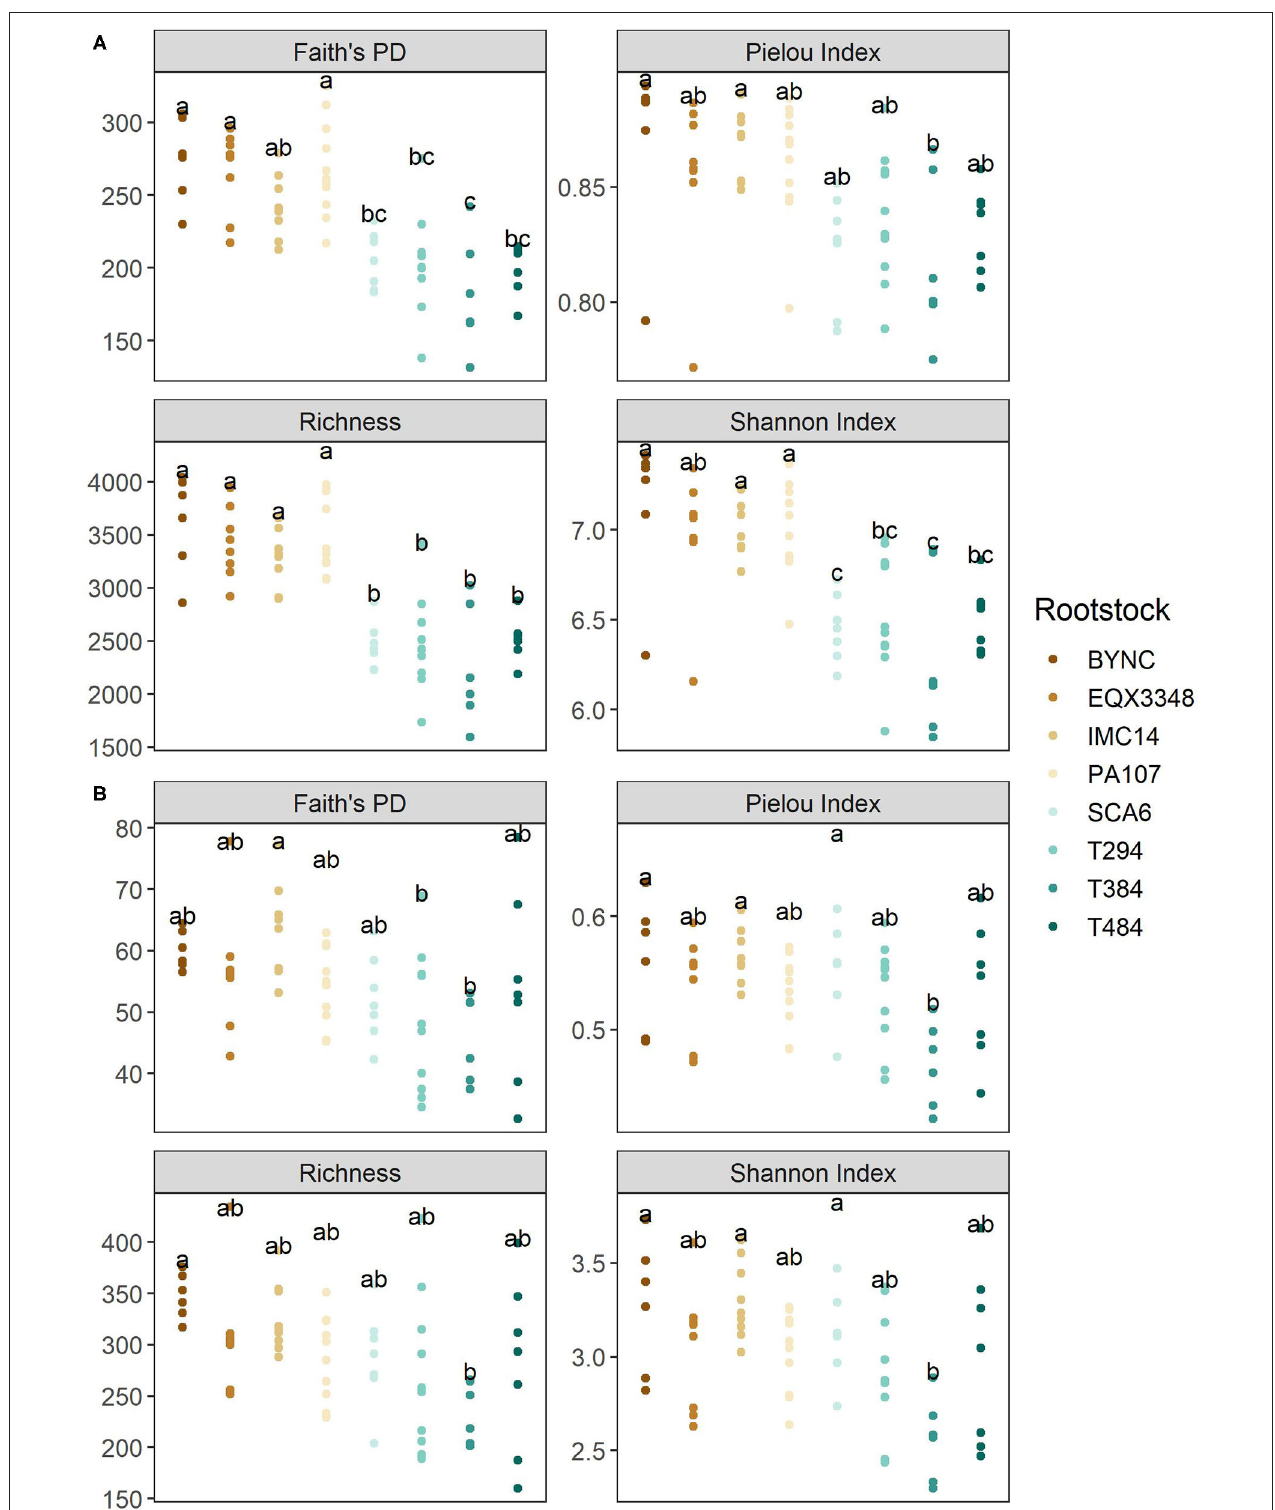
FIGURE 2 | Cacao rootstock effects on microbial alpha diversity. (A) In bacterial communities, Faith’s PD (a diversity metric that accounts for phylogeny), the Pielou and Shannon indices (integrating richness and evenness), and taxonomic richness were significantly affected by rootstock (all p < 0.05). Lower diversity was observed in bacterial communities associated with SCA6, T294, T384, and T484. (B) In fungal communities, rootstock identity significantly affected all measures of alpha diversity (all p < 0.05). Fungi associated with T384 showed the lowest alpha diversity.